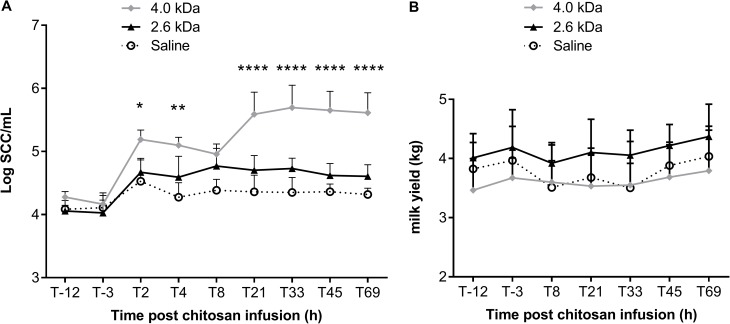
Relative innocuity of different forms of chitosan in cows.Each quarter of cow’s udder has received 500 mg of chitosan (2.6 kDa or 4.0 kDa) or saline as the negative control. Milk samples and somatic cell counts (SCC) were determined 12 and 3 hours before the instillation of chitosan. After the intramammary instillation, milk samples were aseptically collected from cows at several points in time to evaluate inflammation by determining the SCC (A) and milk yields (B). Symbols represent the means and vertical lines the standard deviation. Data were analyzed by ANOVA using the MIXED procedure of SAS (SAS Institute Inc., Cary, NC). For the first experiment, time was used as a repeated effect and treatment (cow) was used as the subject. Orthogonal contrasts were performed to compare the effect of each treatment to control. No difference was observed between saline and the 2.6 kDa chitosan (SCC and quarter milk yield). Significant differences were observed between saline and 4.0 kDa for SCC: *, P<0.05; **, P< 0.01; ***, P<0.0001.